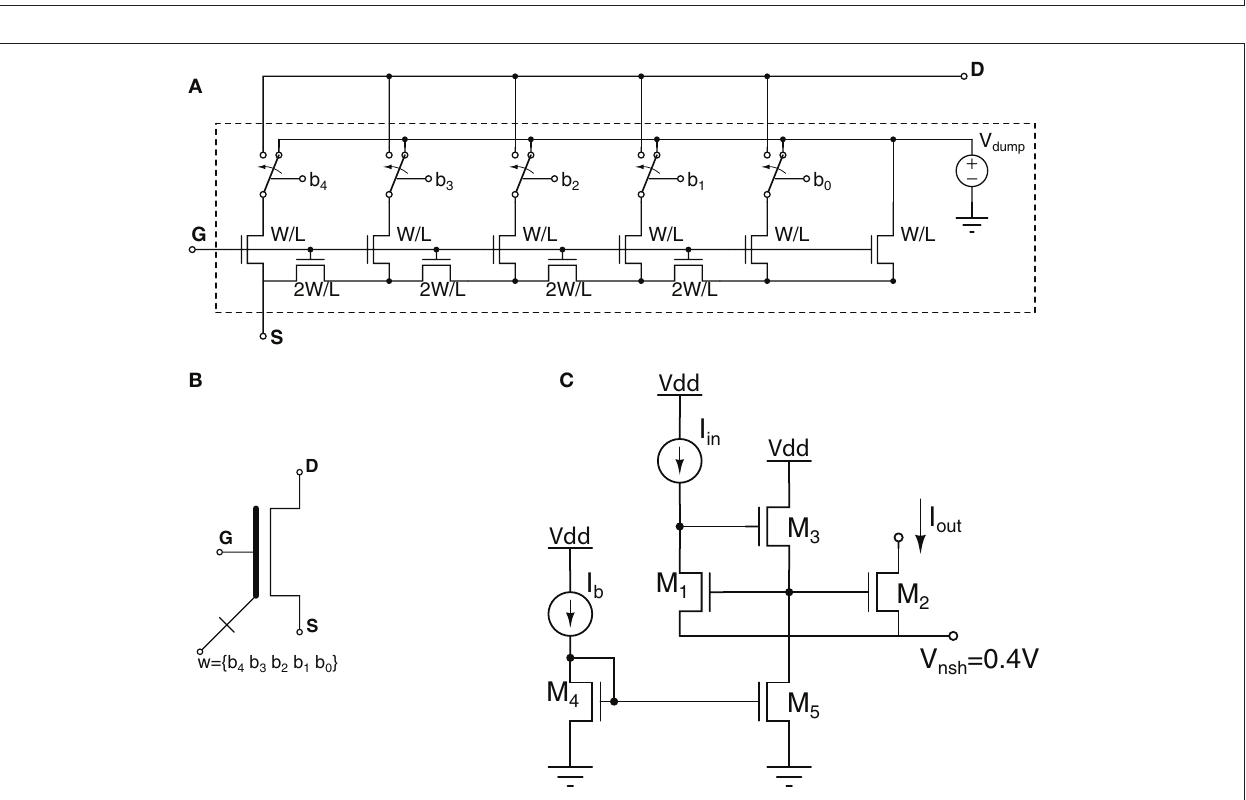
FIgure 7 | (a) Digi-MOS: MOS transistor with digitally adjustable size factor ( W/L ) circuit symbol; (C) Very low current mirror: Circuit with negative gate-to-source voltage biasing for copying very low